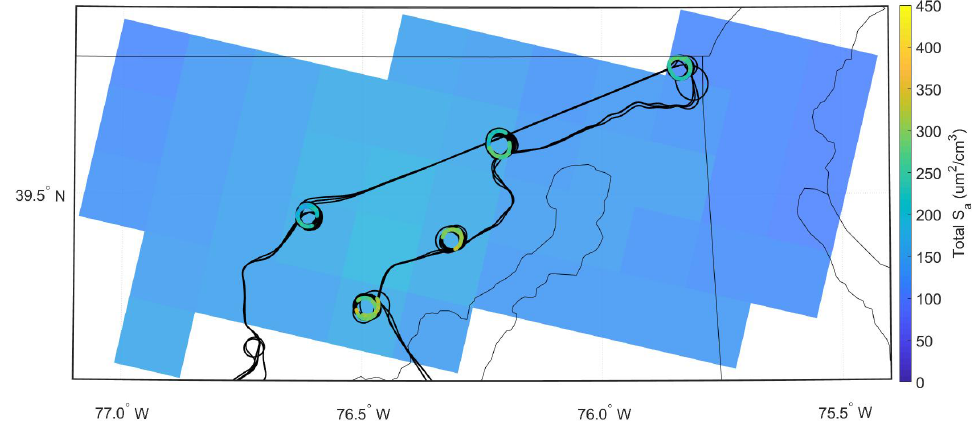
Figure 9. Flight path from 28 July with overlaid UHSAS S a data within the 10th layer of CMAQ altitude ( ∼ 850–1000m) and gridded CMAQ S a from layer 10 in the background. The CMAQ data are specifically at noon EST (16:00UTC).